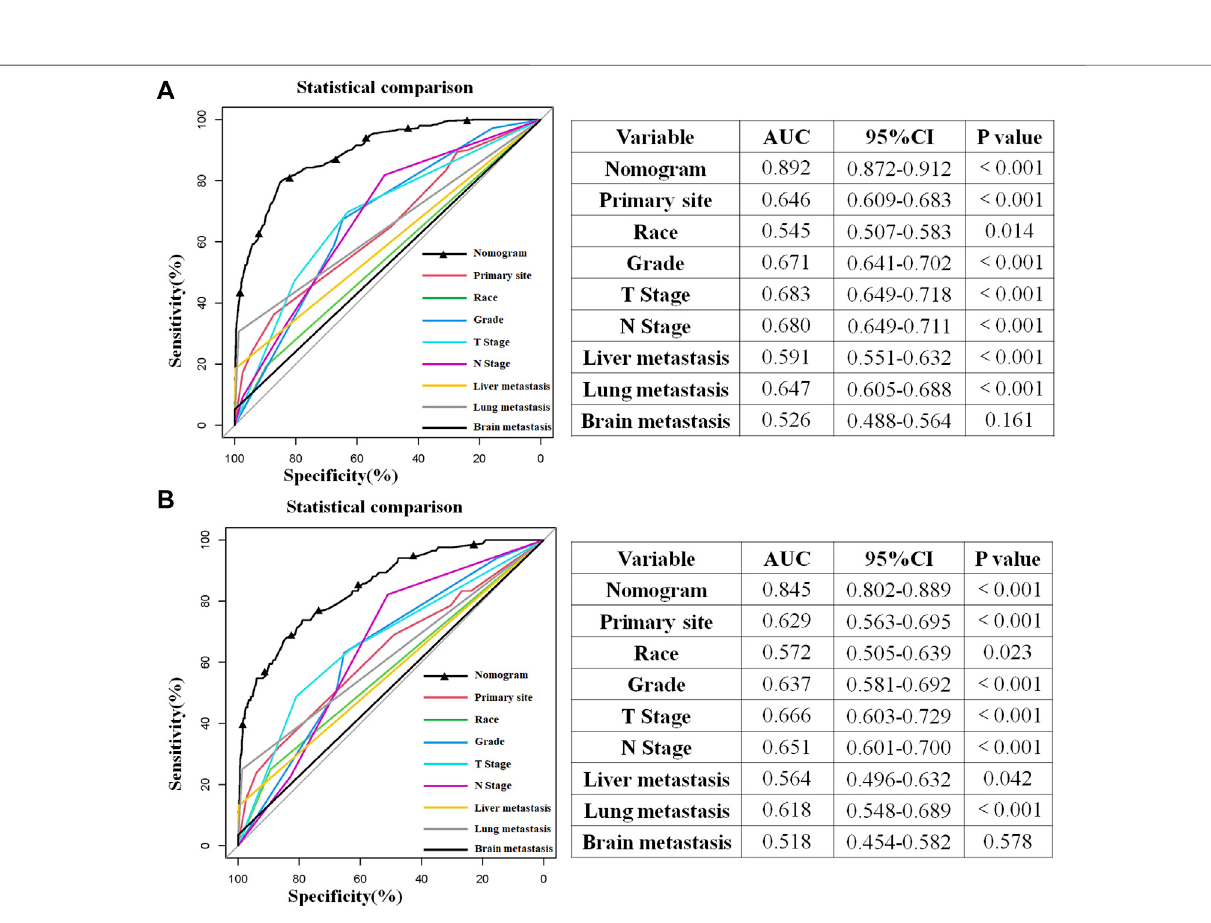
Frontiers in Genetics |